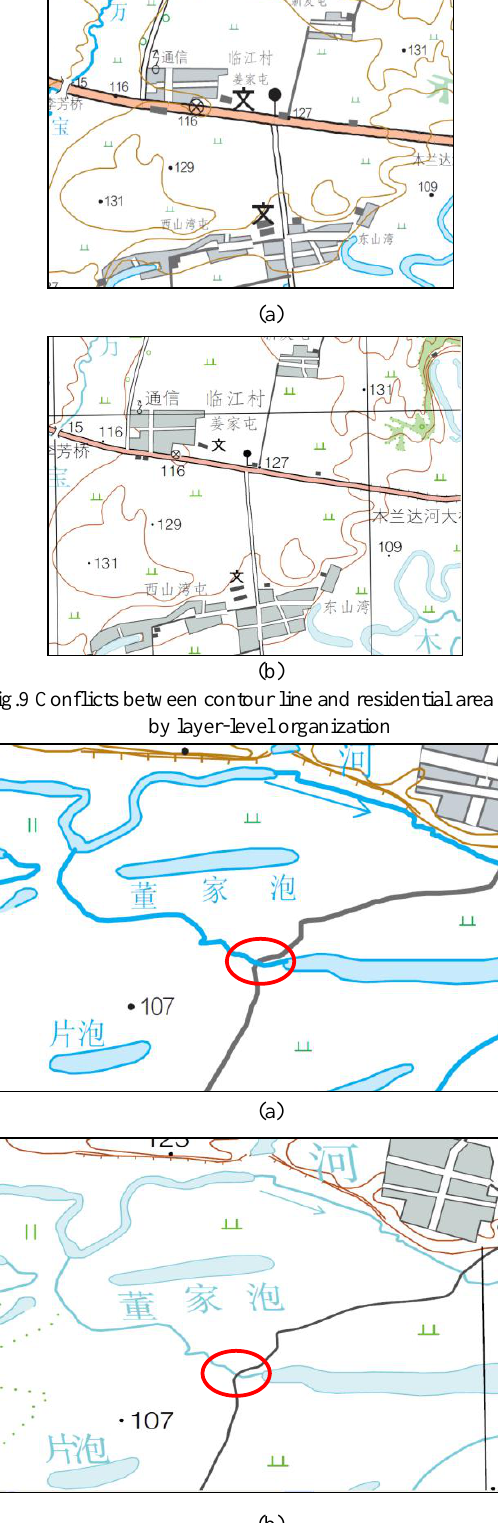
Fig.10 Conflicts between river and road solved by layer-level